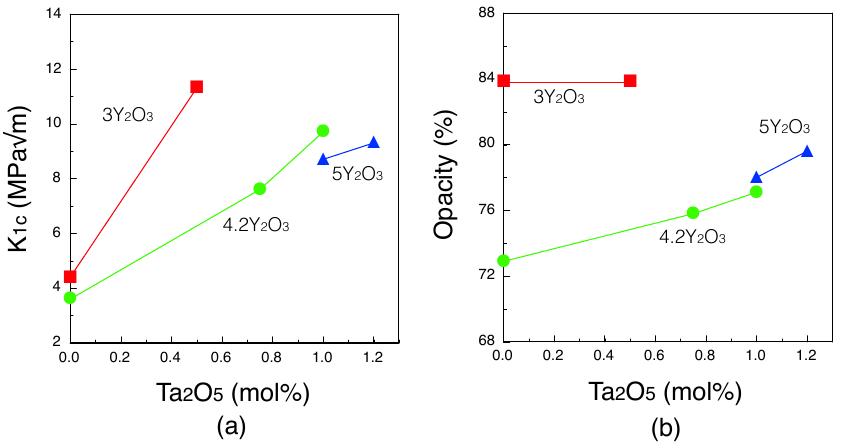
Figure 5. The effect of Ta 2 O 5 content on ( a ) fracture toughness and ( b ) opacity of ZrO 2 -Y 2 O 3 -Ta 2 O 5 (No. 2, 3 and 23–27).